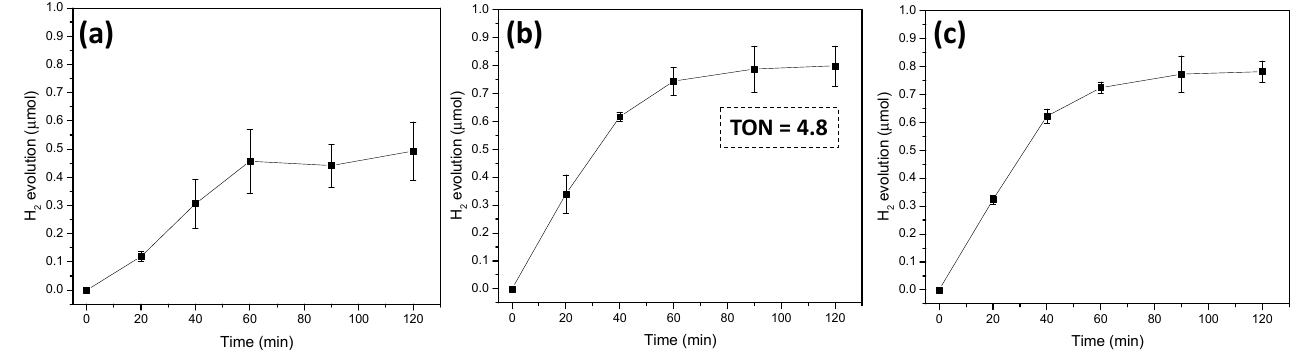
Figure 8. Photocatalytic hydrogen production as a function of the pH: ( a ) 4.5; ( b ) 5.0; and ( c ) 5.5. The photon flux was a parameter that was tuned to determine the limitation of the system related to the light intensity projected on the surface of the photocatalytic system. These experiments were carried out by placing two neutral density filters (60% transmittance and 30% transmittance) in front of the LED lamp (Figure 9). Minor deviations of the hydrogen evolution were observed with the 60% transmittance filter compared to the reaction without any filter (within the error). In contrast, a further decrease of the hydrogen productivity generated by the photocatalytic system was decreased. These